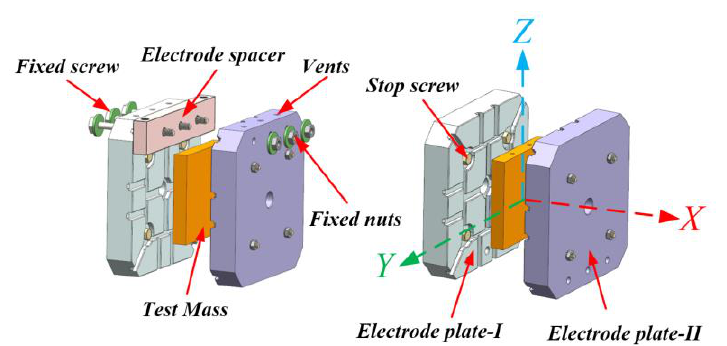
Figure 6. Components of sensitive structure.